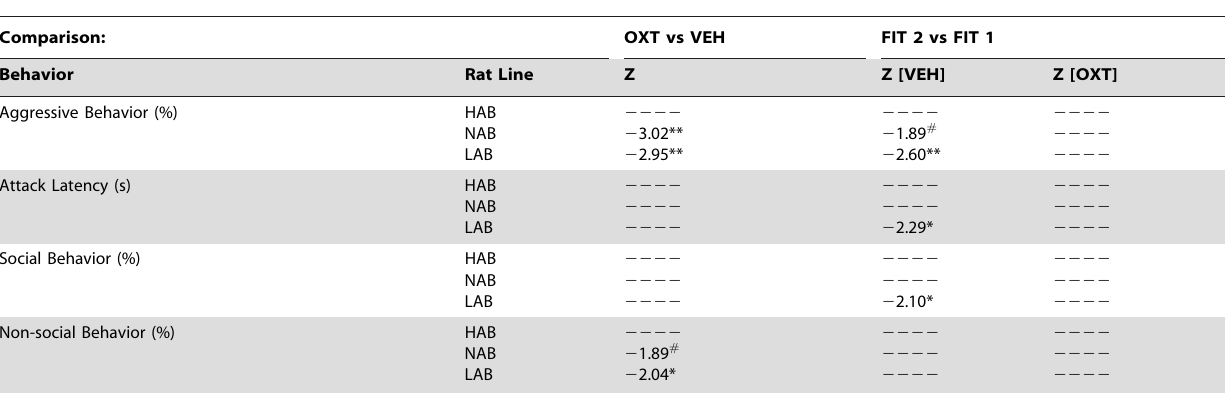
Mann-Whitney pair-wise comparisons for experiment 3 (Fig. 4). **P , 0.01, *P , 0.05; # P=0.06.